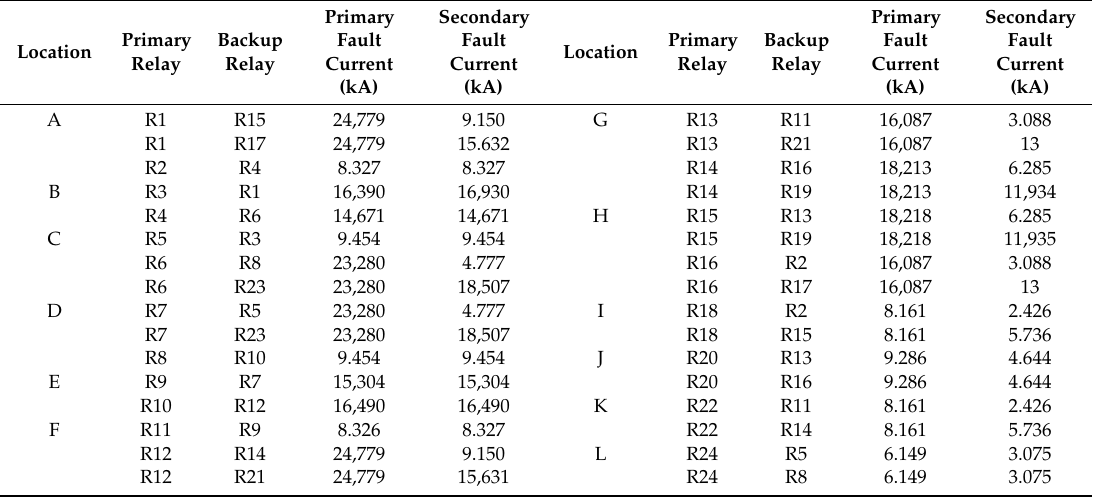
Table 3. Fault currents of primary an backup relays for the IEEE 9 bus system understudy [36].